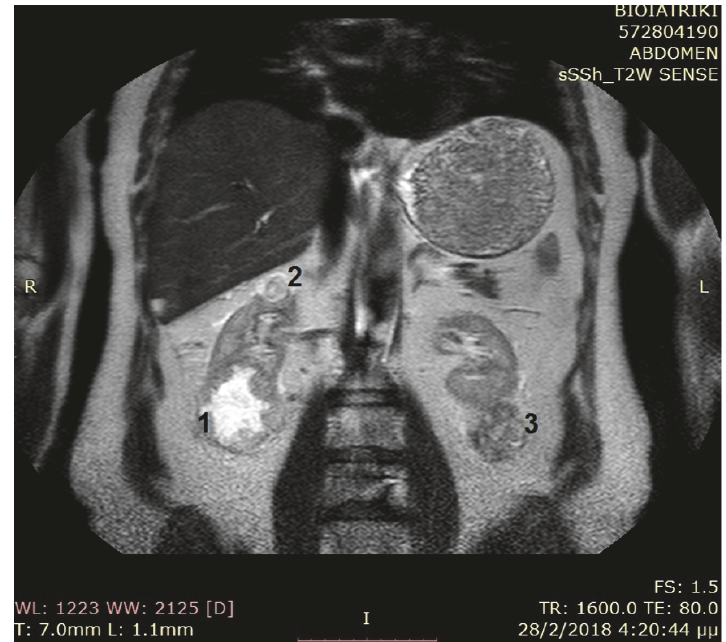
Figure 1: T2-weighted coronal MRI image demonstrating a 6.2x6.3 cm in size, solid mass at the lower pole of the right kidney (1), a 2.4 cm solid mass at the upper pole of the right kidney (2), and a 5.4x4.5 cm in size, solid mass at the lower pole of the left kidney (3).